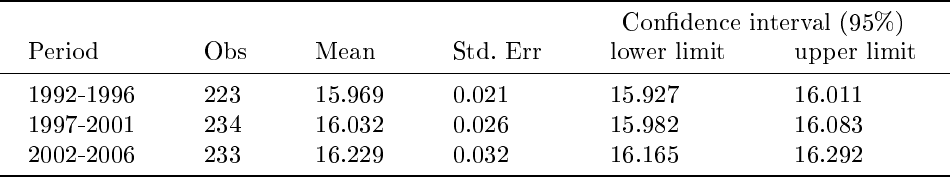
Table 4: Con(cid:28)dence interval of the dependent variable LOG (House price), mean, and standard